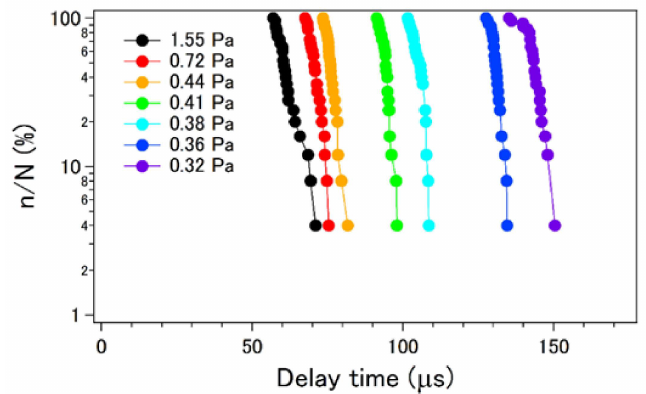
Figure 8. Laue plots for the electrical breakdowns of N = 25 in MPPMS for the working pressure in the range of 0.32 to 1.55 Pa.